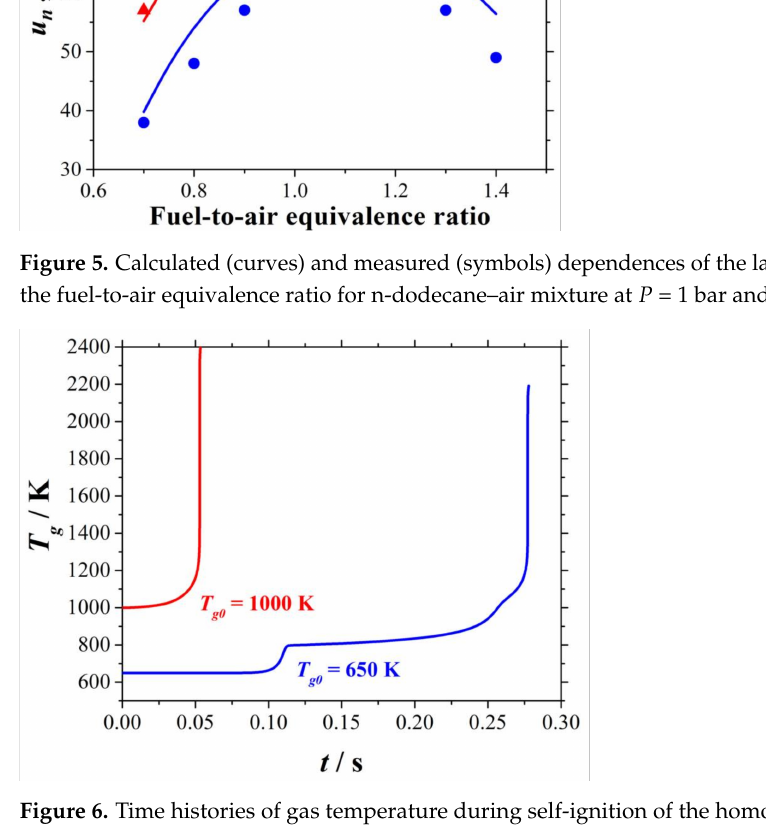
Figure 6. Time histories of gas temperature during self-ignition of the homogeneous stoichiometric n-dodecane–air mixture at P = 1 bar and T g 0 = 650 K and 1000 K (no